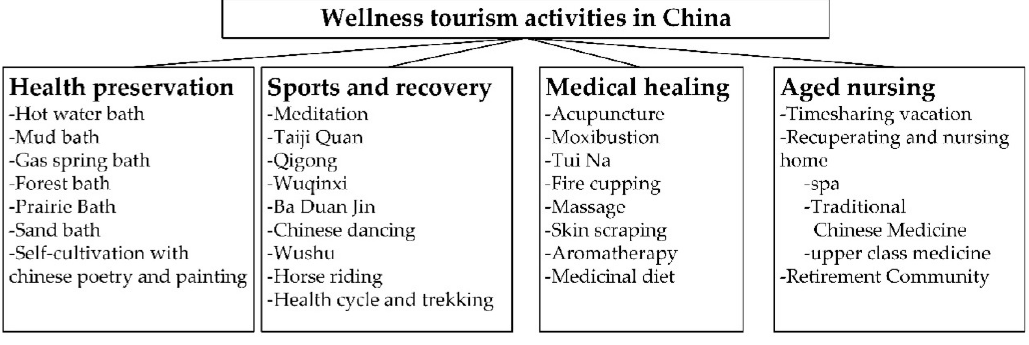
Fig. 1 The construction of a three-level index system for the core competitiveness of the martial arts